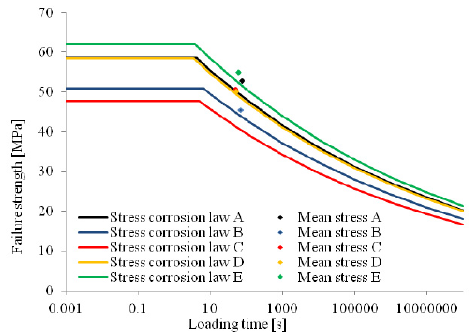
(m -1/2 ) vs. the failure strength σ m